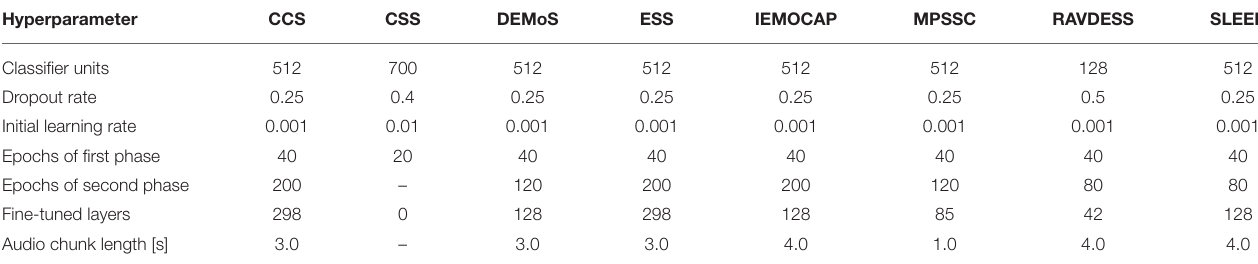
TABLE 2 | This table shows the configuration of the different hyperparameters for each of the datasets used in our experiments.